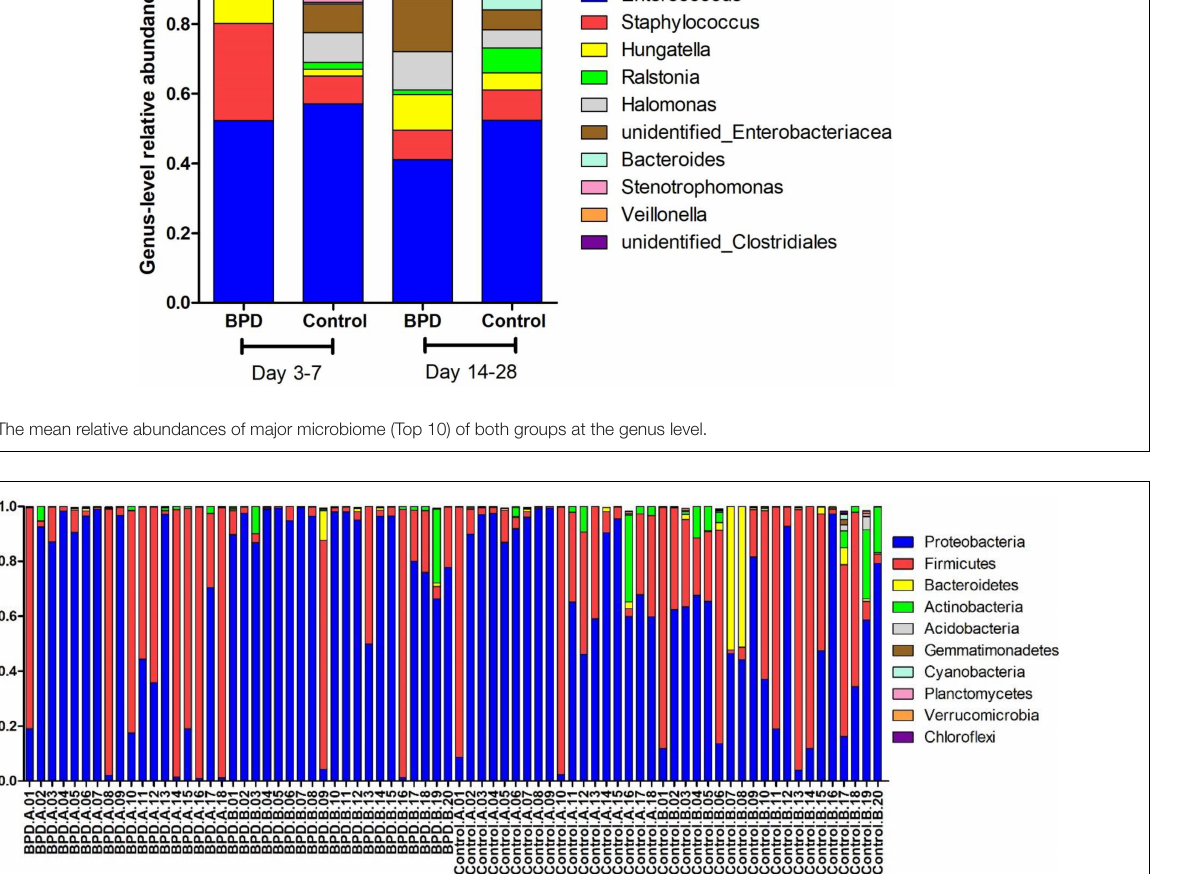
FIGURE 3 | The mean relative abundances of major microbiome (Top 10) of every infant at the phylum level. BPD.A: The infants with BPD on days 3–7. BPD.B: The infants with BPD on days 14–28. Control A: The infants without BPD on days 3–7. Control B: The infants without BPD on days 14–28.